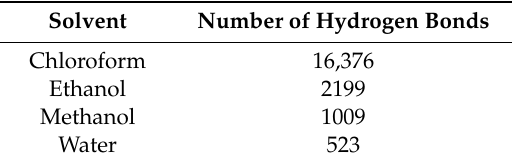
Table 4. Hydrogen bond number analysis in simulation trajectory.